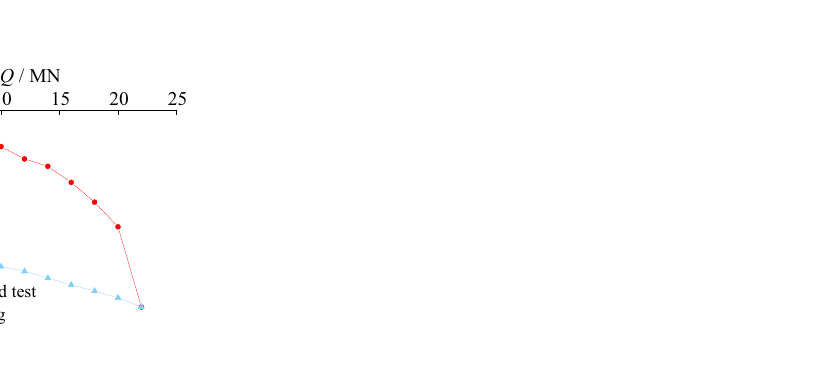
Figure 6. Load-settlement curves of test